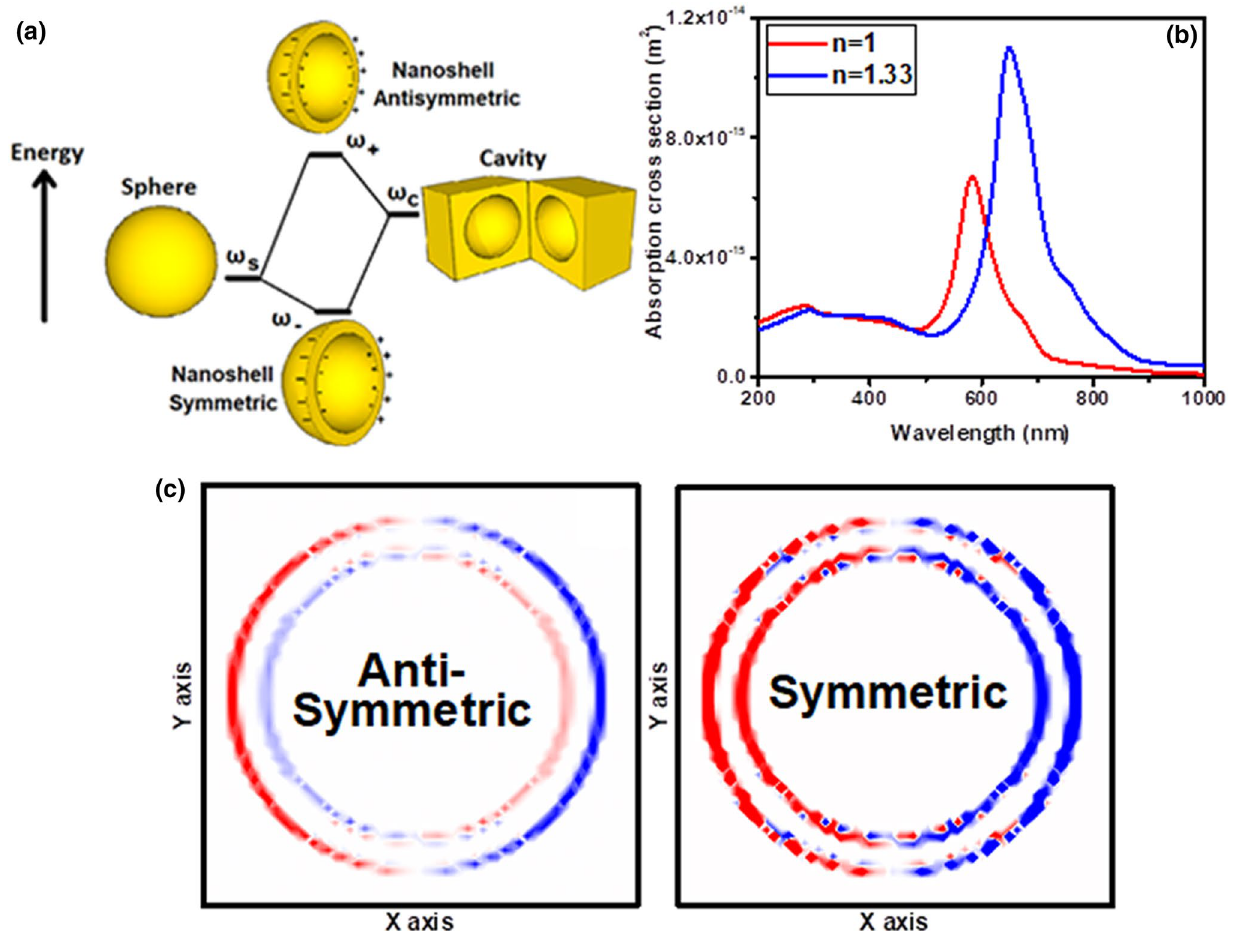
Figure 3. ( a ) Energy-level diagram describing the plasmon hybridization mechanism of nanoshells: Effect of shell thickness on the interaction between a sphere (resonance frequency, ω s ) and a cavity plasmon (resonance frequency, ω c ). There are two modes of plasmonic oscillations: antisymmetric mode with the resonance frequency ω + and symmetric mode with the resonance frequency ω − . ( b ) Absorption cross section of versus refractive index of surrounding medium, n. ( c ) Charge density distribution of the spherical nanoshell at its symmetric and asymmetric resonance modes. Browser-based version of SketchUp, https ://app.sketc hup.com, and Origin 2020 version, https ://www.origi nlab.com, have been used for drawing images and making figures,